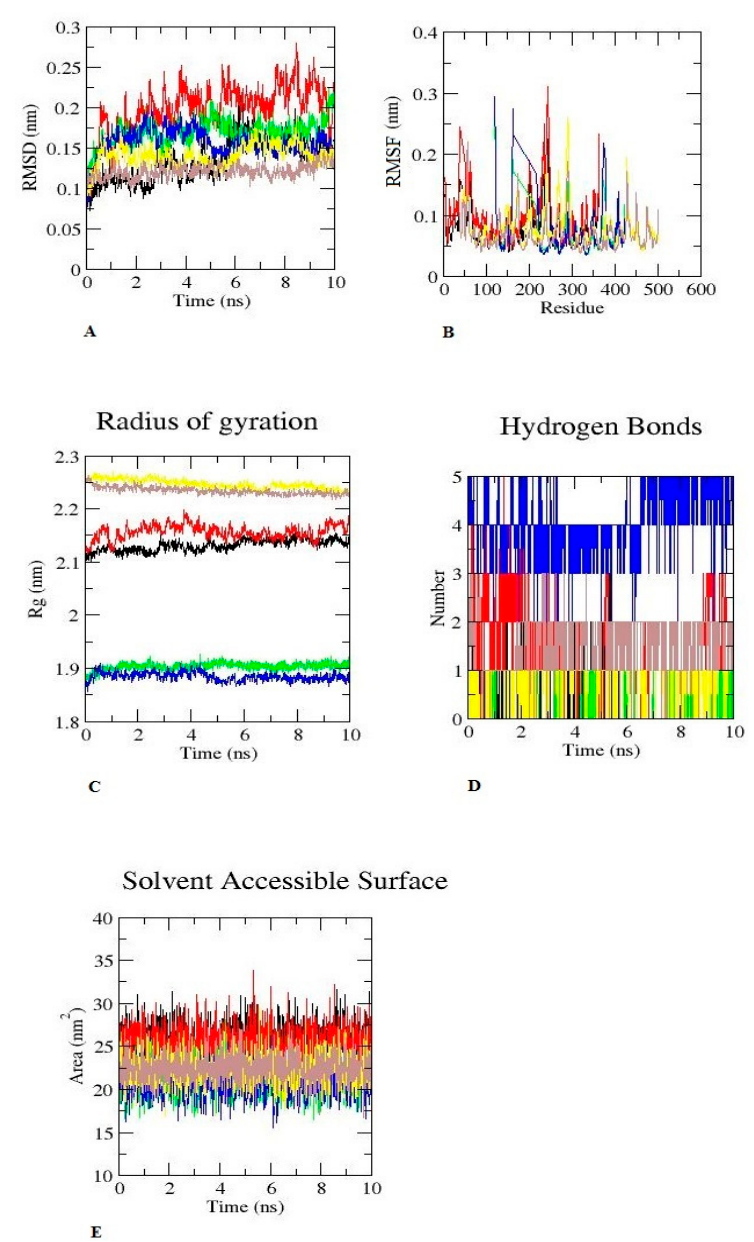
Figure 8. Molecular dynamic (MD) simulation. Black colour is for the vitamin D binding protein+ octocrylene. Red colour is for the vitamin D binding protein + calcitriol. Green colour is for the vitamin D receptor + octocrylene. Blue colour is for the vitamin D receptor + calcitriol. Yellow colour is for the enzyme CYP2R1 + octocrylene. Brown colour is for the enzyme CYP2R1 + calcitriol. ( A ) RMSD for 10 ns. ( B ) RMSF for to 10 ns. ( C ) Radius of gyration corresponds to 10 ns. ( D ) Number of hydrogen bonds between the ligand and the receptor. ( E ) SASA for 10 ns.